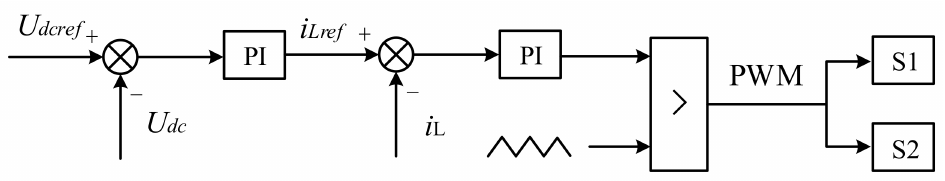
Figure 6. The control strategy of the bidirectional DC–DC converter.